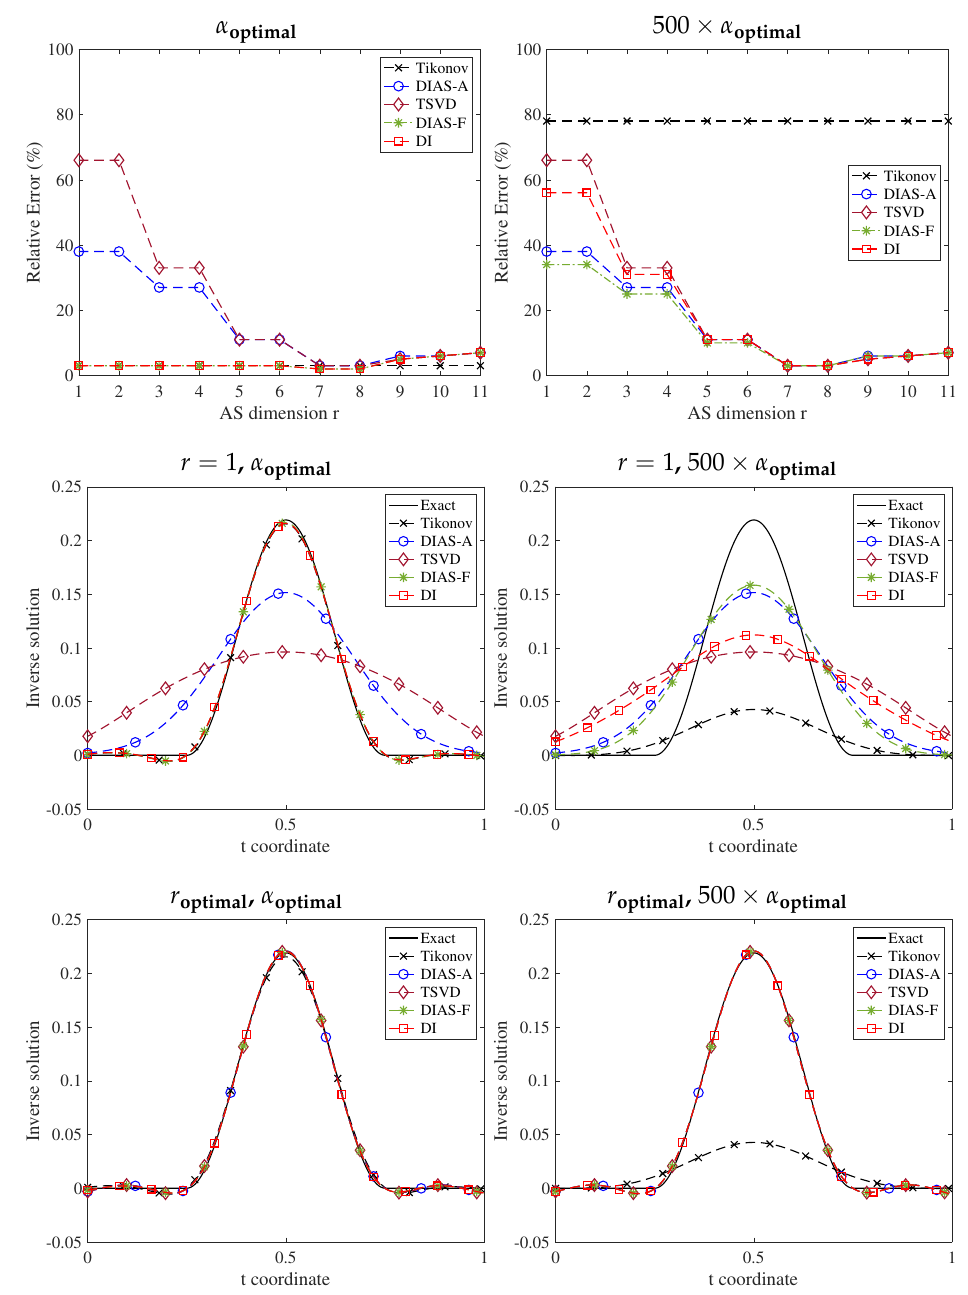
Figure 8. Phillips, α optimal = 0.175. Comparison of different DIAS regularizations and Tikhonov regularization. Top row: relative errors in the inverse solutions for different regularization methods for two values of regularization parameter. Middle row: inverse solutions with DIAS regularizations with one-dimensional active subspace and Tikhonov regularization for two values of regularization parameter. Bottom row: inverse solutions with DIAS regularizations with the optimal dimension active subspace ( r optimal = 8) and Tikhonov regularization for two values of regularization